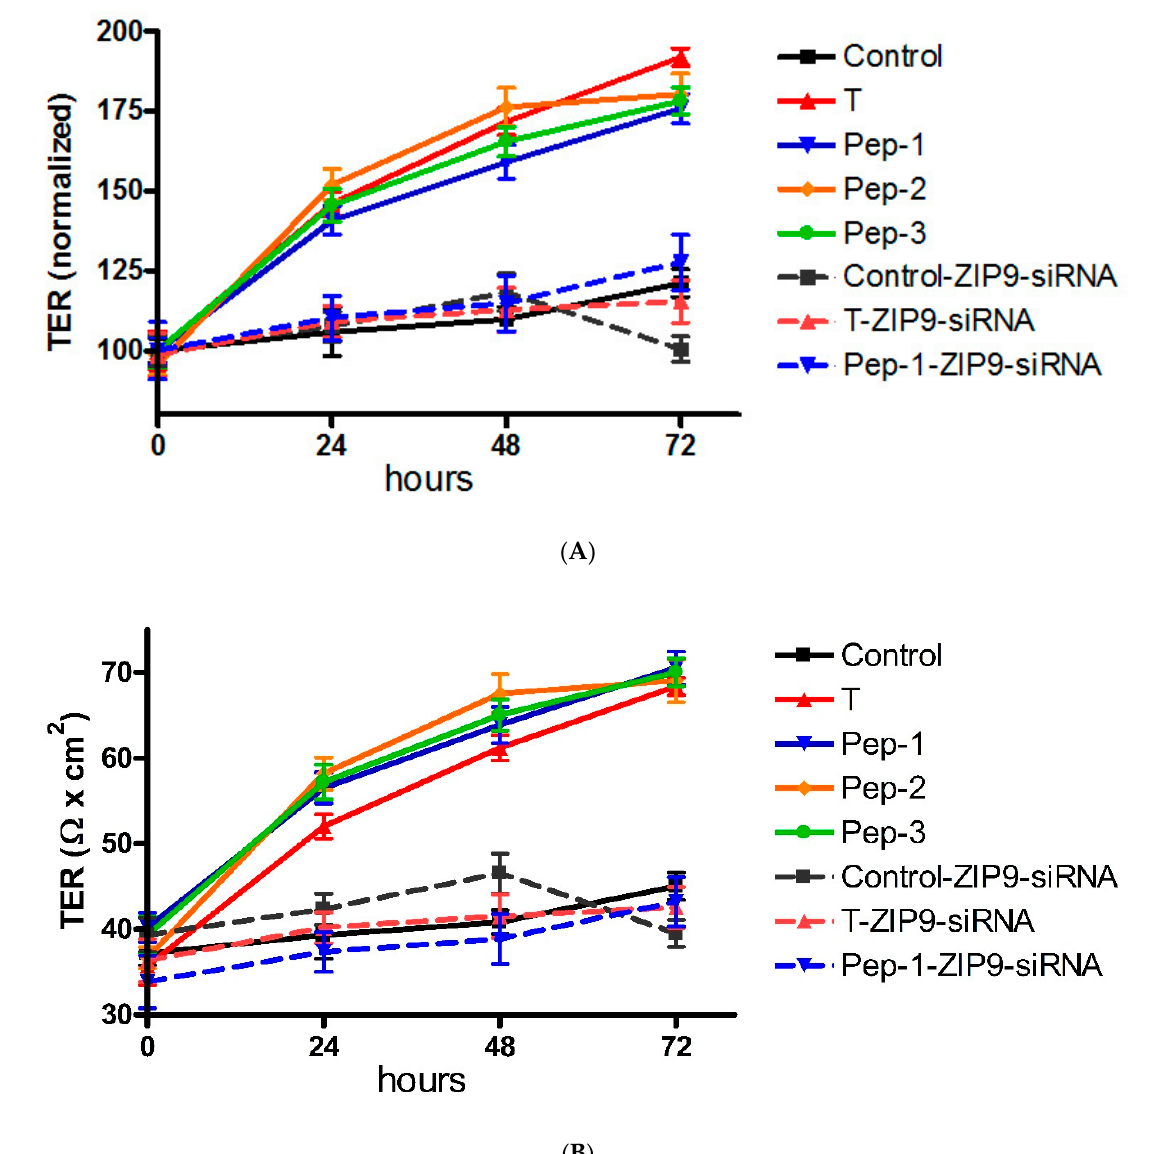
Figure 10. Transepithelial electrical resistance across Sertoli cell layers. The 93RS2 cells were treated with either nc-siRNA or ZIP9-siRNA before exposed to peptides (10 µM) or testosterone (10 nM). IAPG = Pep-1; GVSG = Pep-2; GVVG = Pep-3. ( A ) Measurements of TER were taken after 0, 24, 48 and 72 h. ( B ) Normalization of results shown in ( A ). For each data point: n = 6; means ± SEM).